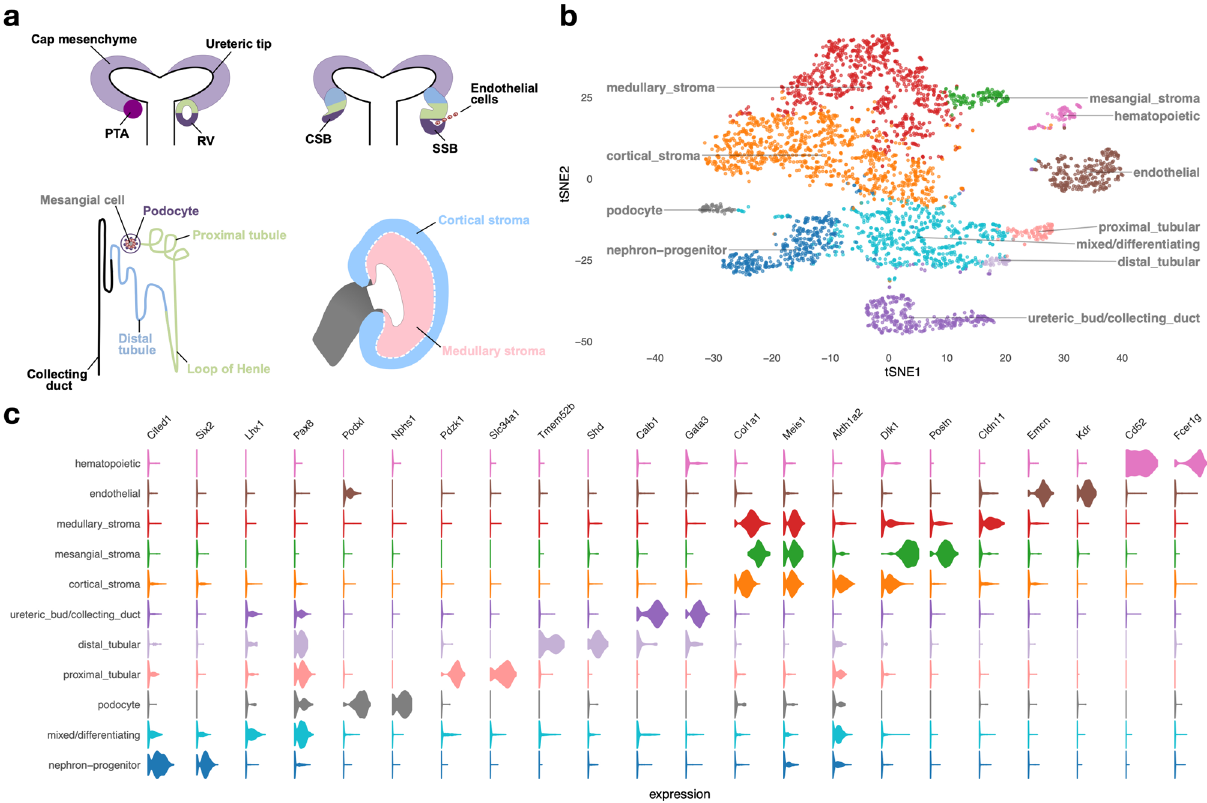
Figure 1. Developing embryonic day 14.5 mouse kidney cell types. (a) Schematic illustration of nephron induction and patterning. In response to signals from the ureteric bud, the metanephric mesenchyme condenses and forms a cap of nephron progenitors (= cap mesenchyme) around the ureteric bud tips. Next, a sub-population of nephron progenitors undergoes a mesenchymal to epithelial transition to form pre-tubular aggregates (PTA), which develop sequentially into renal vesicles (RV), comma-shaped body (CSB) and S-shaped body (SSB). Endothelial cells are attracted into the cleft of the SSB. Color-coded map indicates the cell fate relationship of progenitor regions in SSB structure (upper right) and adult nephron structure (lower left). Schematic of a lateral view of the metanephric kidney depicting the cortical and medullary stroma (lower right). (b) tSNE plot showing the eleven cell clusters in the embryonic mouse kidney, with cell clusters corresponding to major components indicated by color. (c) Violin plots of gene expression for known lineage-associated genes (columns), stratified by cluster (rows). Our data clearly identifies cells from the major structural components of the developing